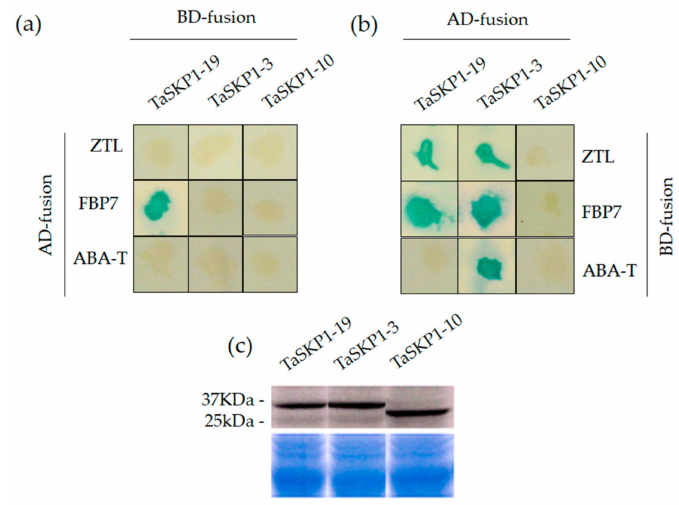
Figure 8. ( a ) and ( b ) Interactions of three TaSKP1 (TaSKP1-19, -3 and -10) proteins with three FBX proteins (ZeitLoop: ZTL, ABA-Tubby: ABA-T, and FBX7: FBP7) determined using yeast two-hybrid (Y2H) analysis. To generate prey (AD-fusion) and bait (BD-fusion) constructs, we fused full-length TaSKP1 and FBX proteins with the GAL4 activation and GAL4 DNA binding domains, respectively. The constructs were tested with both combinations through X-gal assays showing a blue color for positive interactions whereas non-interacting proteins remained white. ( c ) Immunoblot analysis of TaSKP1 and FBX proteins fused to the Gal4 DNA-binding